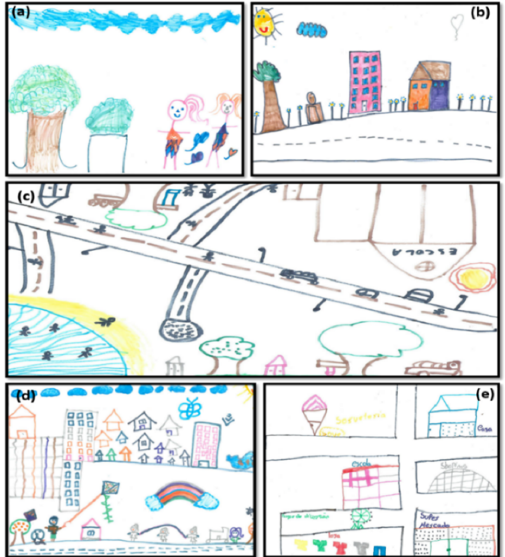
Figure 2. Representative drawings of the Quality of Life (QoL) neighborhood, Brazilian children, aged 6–10 years, urban area. ( a ) C1-S3: 6-year-old girl, ( b ) C4-S5: 7-year-old girl, ( c ) C5-S1: 8-year-old girl, ( d ) C7-S4: 9-year-old girl, ( e ) C7-S1: 10-year-old-girl. C: child; S: school.